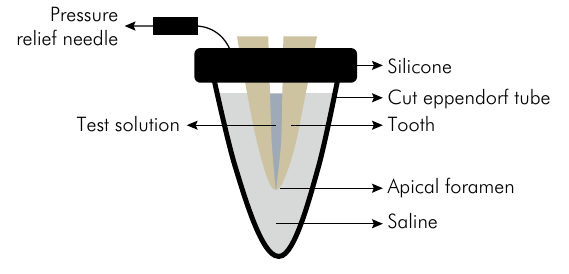
Figure 1. Schematic of the test system. The sample was attached to an Eppendorf tube using an individual silicone plug. A disposable 27-G needle was inserted into the silicone plug to balance the internal and external pressures. The Eppendorf tube was filled with 0.8 mL of sterile saline solution. The root canal was filled with 0.02 mL of the test